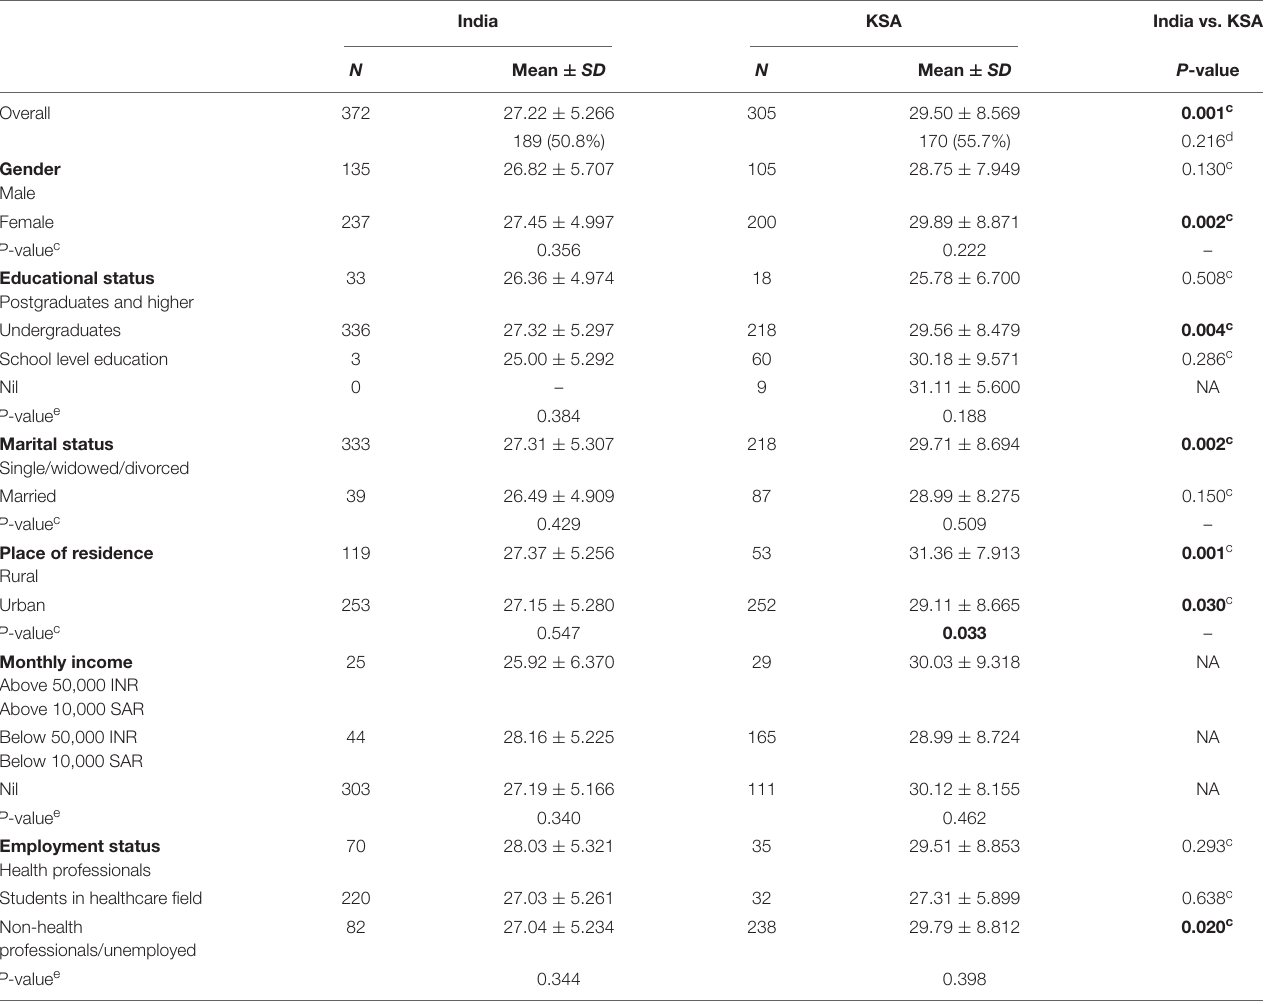
TABLE 5 | Comparison of COVID-19 vaccine hesitancy scores stratified by sociodemographic variables between India and Saudi Arabia.